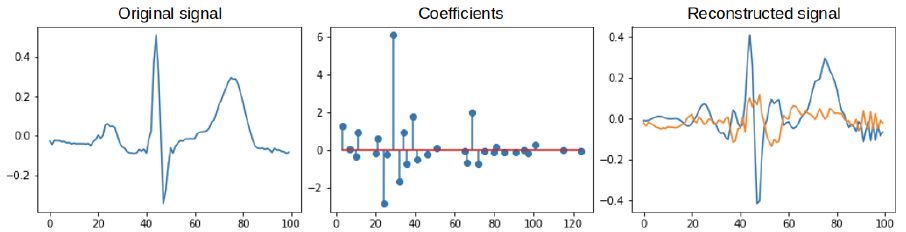
Figure 6. Atoms with non–zero coefficients, for example, signal decomposed using 6 non-zero coefficients.